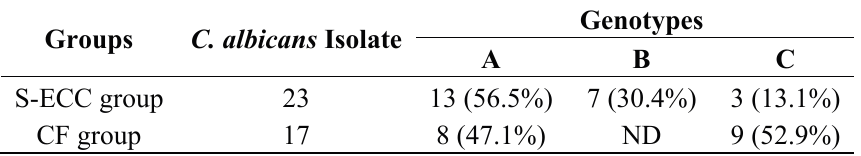
Table 3. Genotypes of C. albicans isolated from different sampling sites in S-ECC and CF